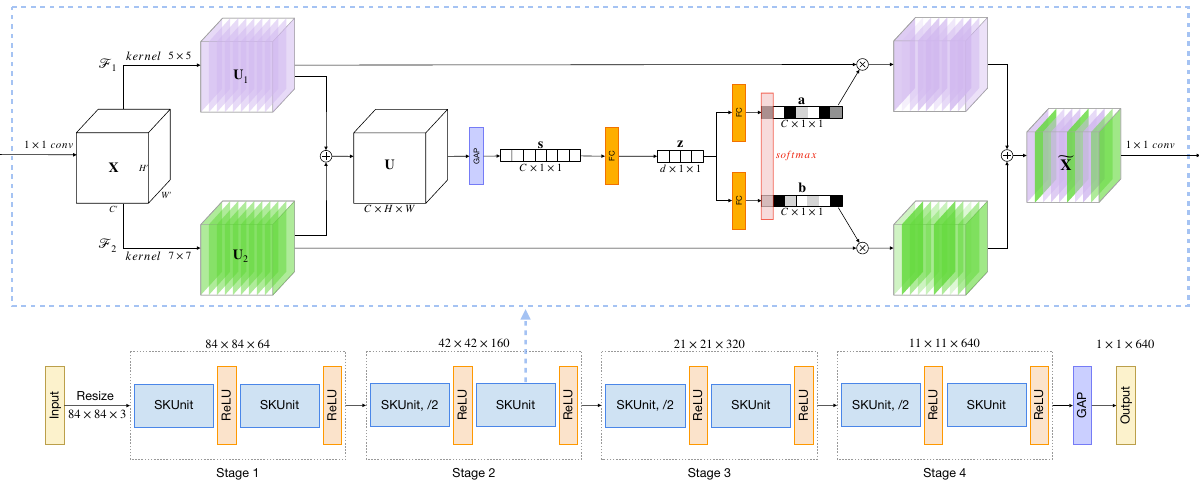
Figure 4. Schematic for the proposed Dynamic Kernel Fusion Network